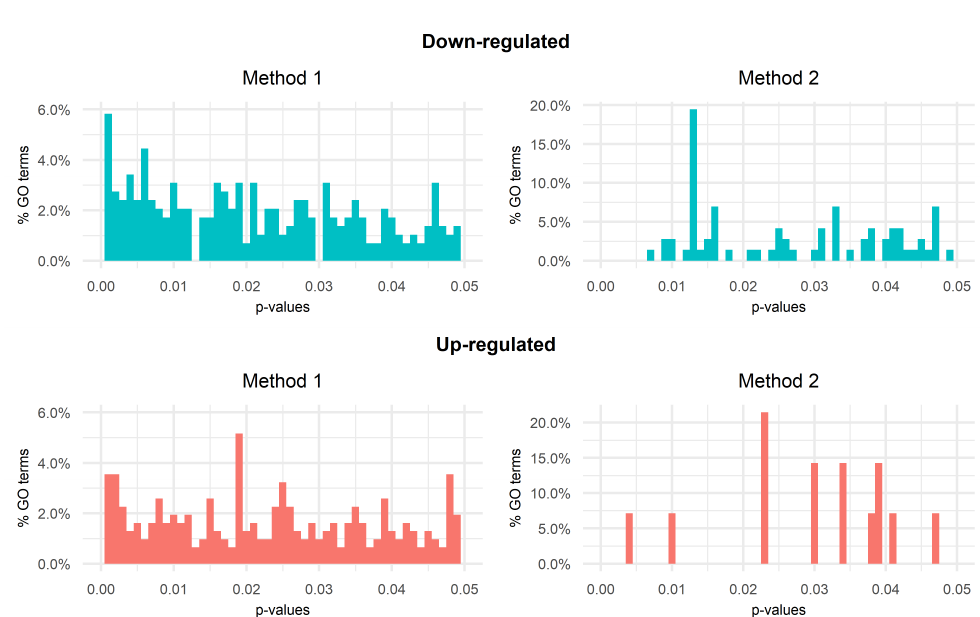
Figure 6. TF-DEGs detected by Methods 1 and 2.